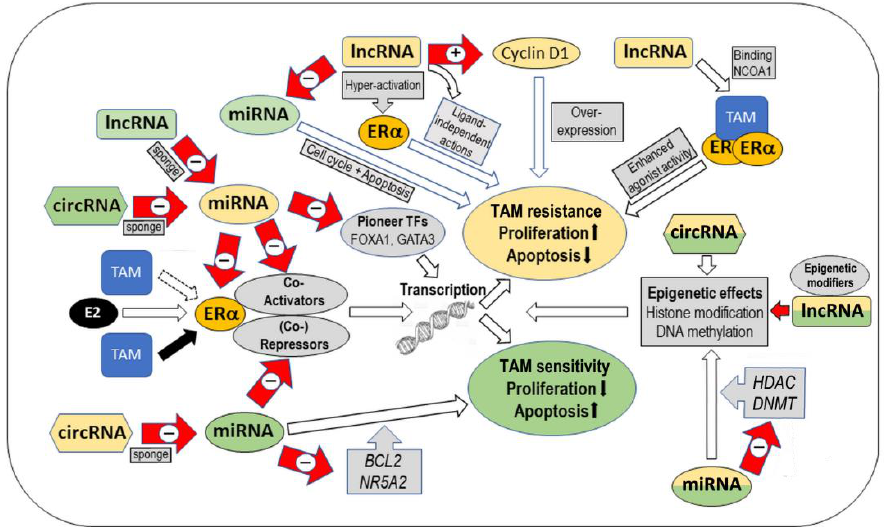
Figure 1. Schematic overview of mechanisms by which ncRNAs affect estrogen signaling and the response to tamoxifen (TAM) in BC cells. Red arrows indicate direct effects of non-coding RNAs. NcRNAs counteracting TAM resistance are colored in light green, ncRNAs in light orange color promote resistance to this SERM. More detailed information on the interactions shown here is provided in the text.